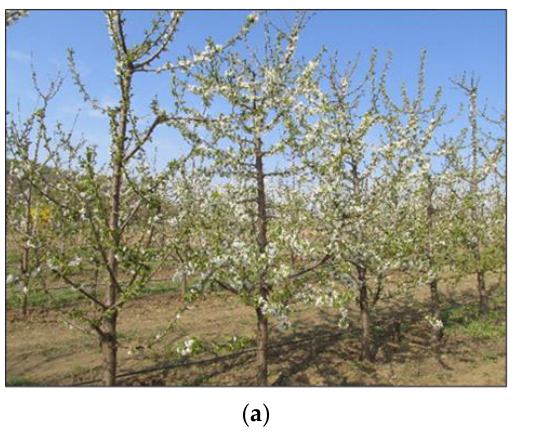
Figure 4. Effect of rootstocks on the branching habit of trees: ( a ) ‘Paulus’: left one tree on SL 64 with upright growth, to the right trees on Bogd á ny with abundant flat branching; ( b ) two ’Rita’ trees left on MaxMa 14, right two trees on Magyar